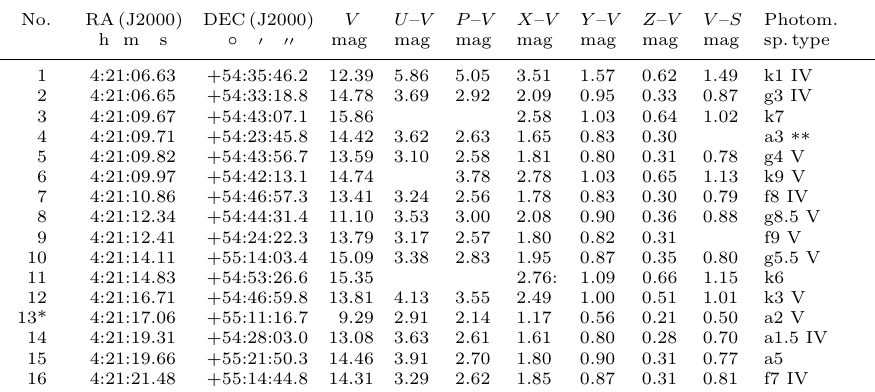
Table 3. Results of photometry and classi(cid:12)cation of stars in the area. The stars with two asterisks in the last column were not classi(cid:12)ed in two dimensions since their images are asymmetrical, i.e., these stars are double or multiple. The components of some of them are seen separately, but they are closer than 7 ′′ . No. RA(J2000)